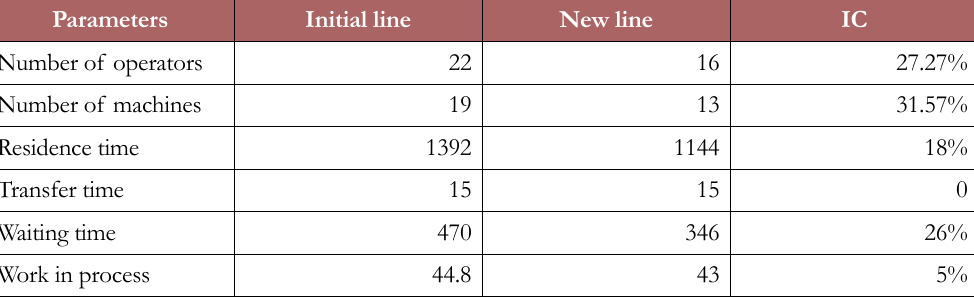
Table 7. Comparison between initial line and new line